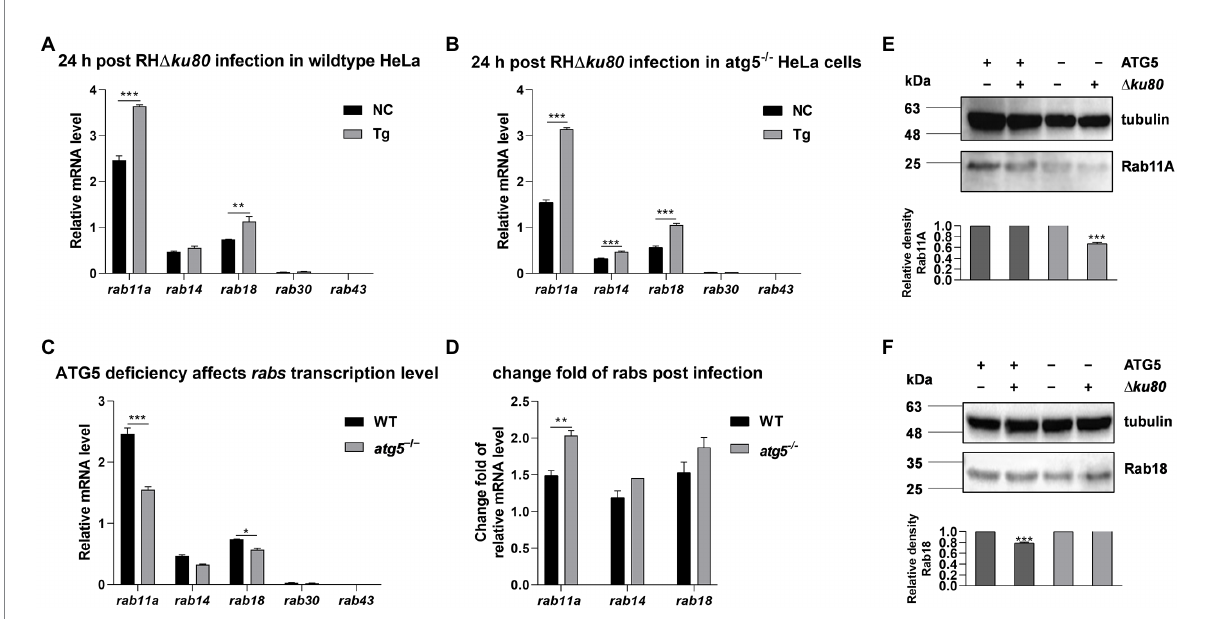
FIGURE 6 Transcripts and proteins of rabs in wild-type and atg5 − / − HeLa cells. HeLa cells were challenged by T. gondii RH ∆ ku80 tachyzoites at an MOI of 2:1, and total RNAs and proteins were extracted 24 h post-infection. The relative mRNA abundance of rabs was quantified by qPCR, tubulin was used as a standard to normalize all data by 2 −ΔΔ CT methods. Each value is the mean ± SEM of three experiments (* p ≤ 0.05; ** p ≤ 0.01; *** p ≤ 0.001; t -tests). (A) The Relative mRNA abundance of rab14 , rab11a, rab30, rab43, and rab18 in untreated and T. gondii infected wild-type HeLa cells at 24 h post- infection. (B) The relative mRNA abundance of rab14 , rab11a, rab30, rab43, and rab18 in untreated and T. gondii infected atg5 − / − HeLa cells at 24 h post-infection. (C) The relative mRNA abundance of rab14 , rab11a , rab30 , rab43, and rab18 in untreated wild-type and atg5 − / − HeLa cells at 24 h post-infection. (D) Fold changes of the transcription of rab11a, rab14, and rab18 due to T. gondii infection in wild-type and atg5 − / − HeLa cells at 24 h post-infection. (E & F) Untreated and T. gondii infected (MOI 2:1) wild-type and atg5 − / − HeLa cells were harvested at 24 h post-infection, and proteins of equal amounts of cell lysates were separated on 15% SDS-PAGE gels. Rab11A (~24 kDa) and Rab18 (~23 kDa) were detected using rabbit anti-Rab11A and anti-Rab18 polyclonal antibodies. The relative densities of Rab11A or Rab18 were the ratios of the densities of Rab11A or Rab18 to the densities of Tubulin. The relative densities of the uninfected cells were set as one arbitrary unit whereas those of the treated groups were ratios to the negative controls. Each value was the mean ± SEM of three measurements (*** p ≤ 0.001; t